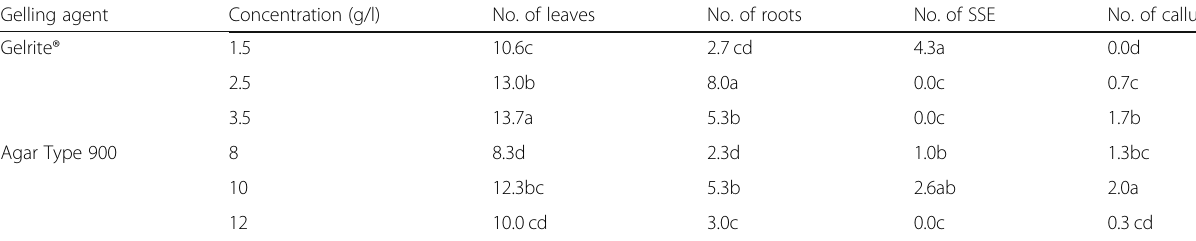
Table 2 Effects of different type of gelling agents on the production of number of leaves, roots, SSE, and callus in oil palm polyembryoids after 60 days of